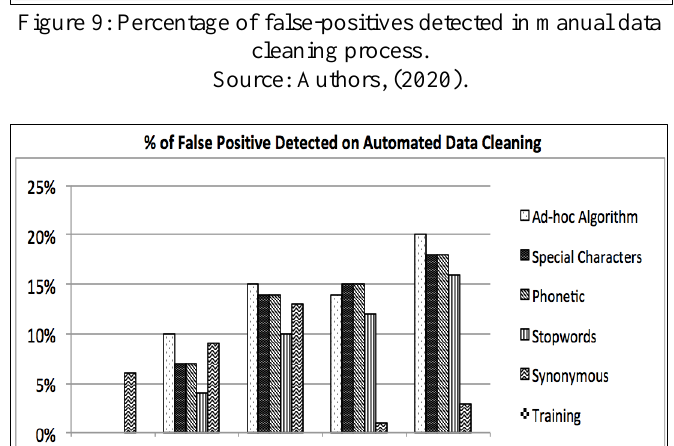
Figure 10: Percentage of false-positives detected in automated data cleaning